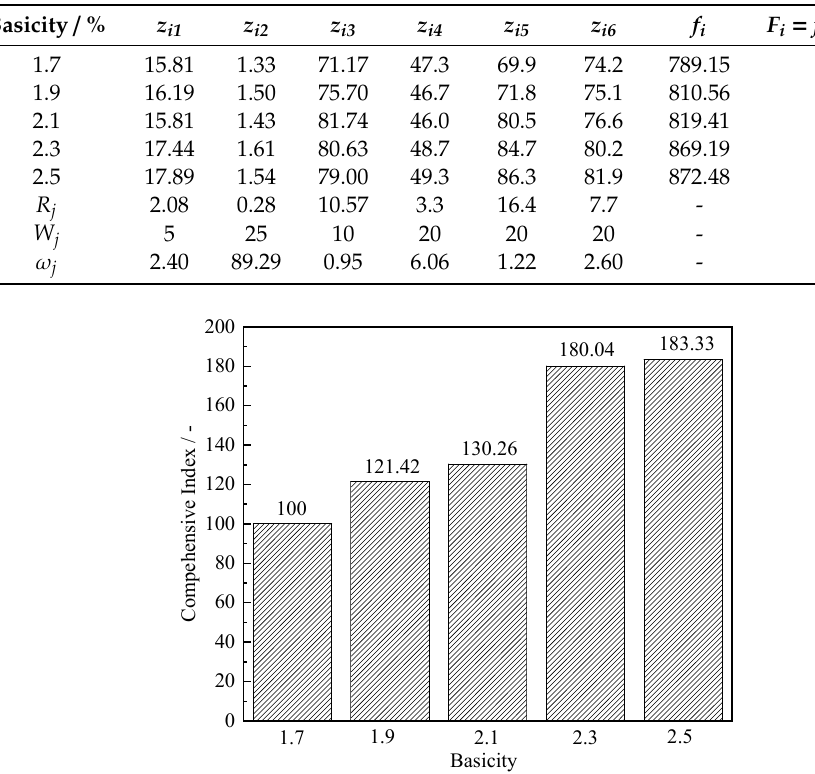
Table 4. Calculation process of the comprehensive index.